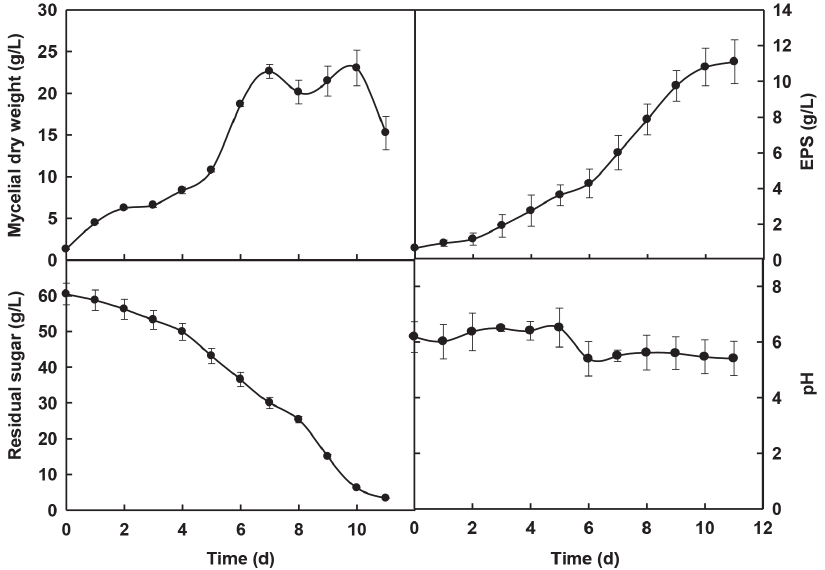
Fig. 1 - Time profiles of mycelial biomass (A) , EPS (B) , residual sugar (C) , and pH (D) in submerged culture of P. geesteranus 5 # in a stirred-tank